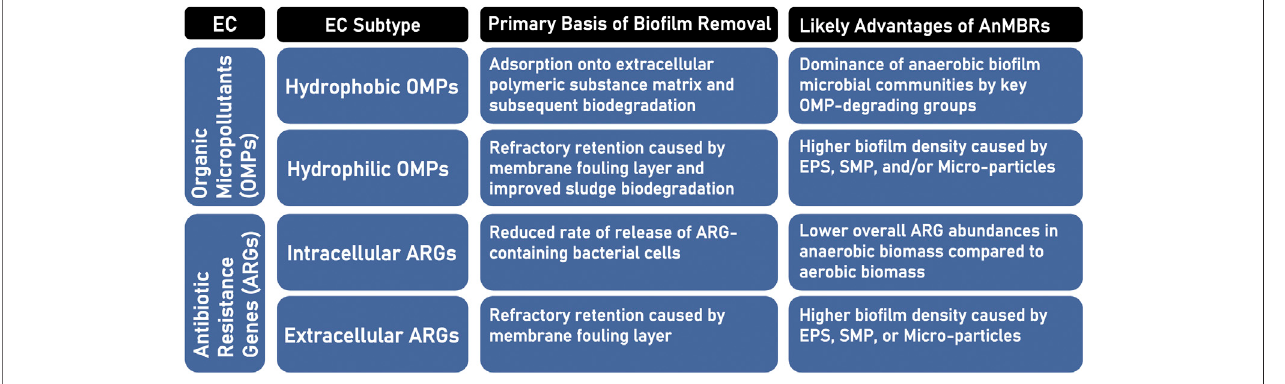
FIGURE 2 | Categorization of the emerging contaminant (EC) types and subtypes addressed in this study, their primary basis for bio fi lm-based removal, and the possible advantages to their removal by anaerobic membrane bioreactor (AnMBR) systems.